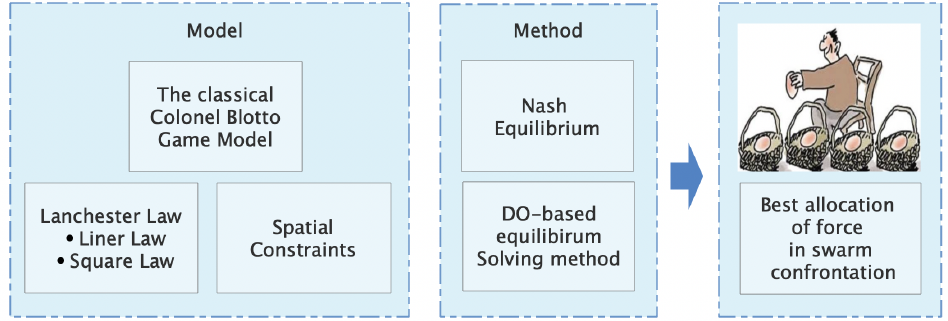
Figure 1. Modeling and equilibrium solving of UAV swarm